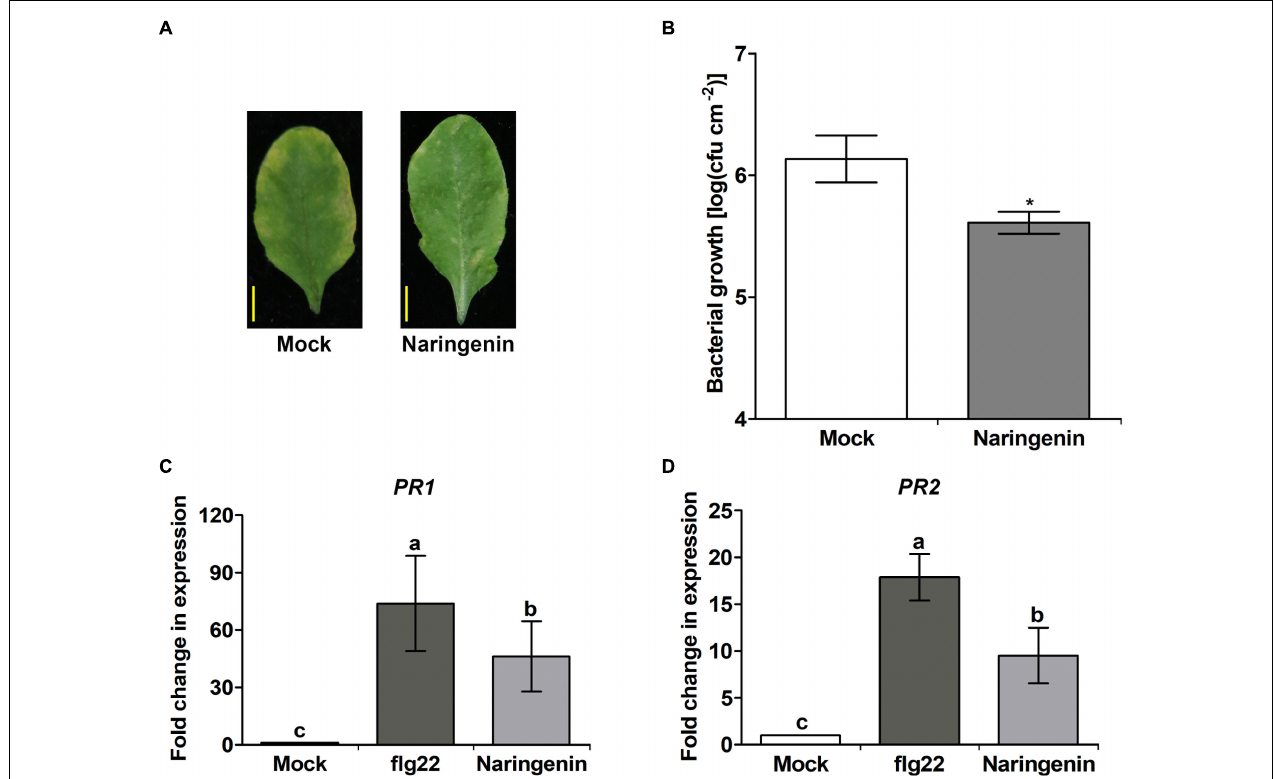
FIGURE 1 | Basal resistance to Pst DC3000 infection of Col-0 plants is enhanced in the presence of naringenin. The growth of Pst DC3000 in control (mock) or in naringenin-pretreated Col-0 plants. Col-0 plants were sprayed with 1 mM naringenin one day before being challenged with DC3000. (A) Disease symptoms of Col-0 plants infected by Pst DC3000 in the absence and presence of naringenin. Photos were taken at three days. (B) Bacterial numbers were quantified three days later. Bars represent mean values (SD) of colony-forming units (cfu) per square centimeter from biological replicate samples derived from different plants. Each biological replicate consists of three leaf disks harvested from different leaves of one plant. Number signs denote statistically significant differences from the Col-0 value (* P < 0.05; two-tailed t -test). Scale bar represents 0.5 cm. The expressions of PR genes are induced by naringenin. Total RNA was extracted from Col-0 plants treated with 0.5 µ M flg22 or 100 µ M naringenin. Samples were collected 24 h post-treatment. Transcript levels of PR gene are increased in Col-0 plants. PR1 (C) and PR2 (D) transcript levels were measured by qPCR using specific primers. Tubulin was used as an internal control. Error bars indicate SD. Different letters above bars indicate statistically significant differences between samples, according to Tukey’s honestly significant difference test ( P < 0.05). The experiment was repeated three times with similar